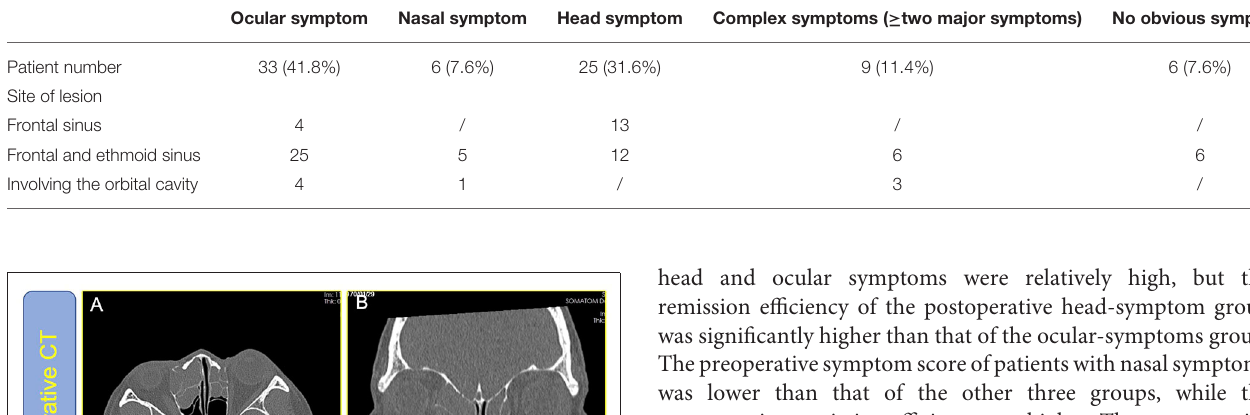
TABLE 2 | Principal symptoms and site of lesion in the study participants ( n = 79).